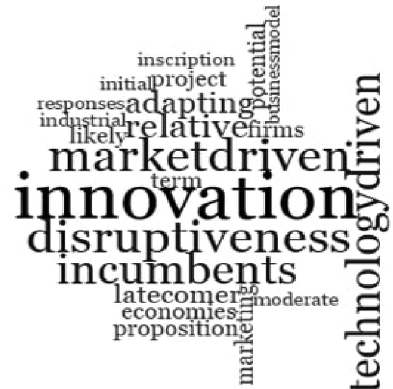
Figure 6. The 4th